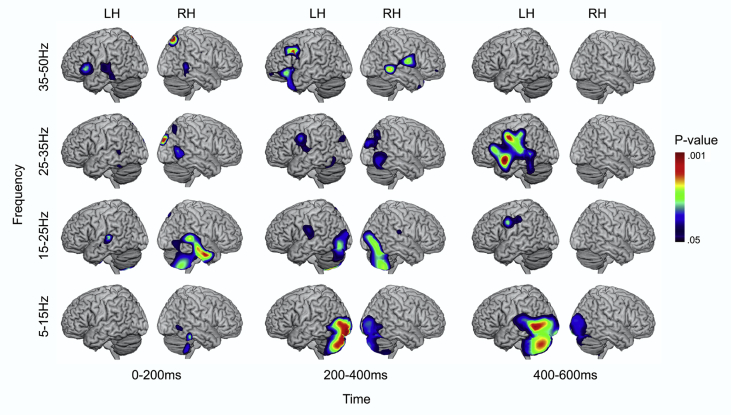
Whole brain beamforming data, comparing an active retrieval period, following the onset of the second word in the pair, with a passive period before the onset of the trial, across all semantically-related trials in four frequency bands. Map shows voxels in the brain with t-values equal or higher than the top 5% t-values present in the null distribution. Images created using MRIcron software (Rorden et al., 2007).